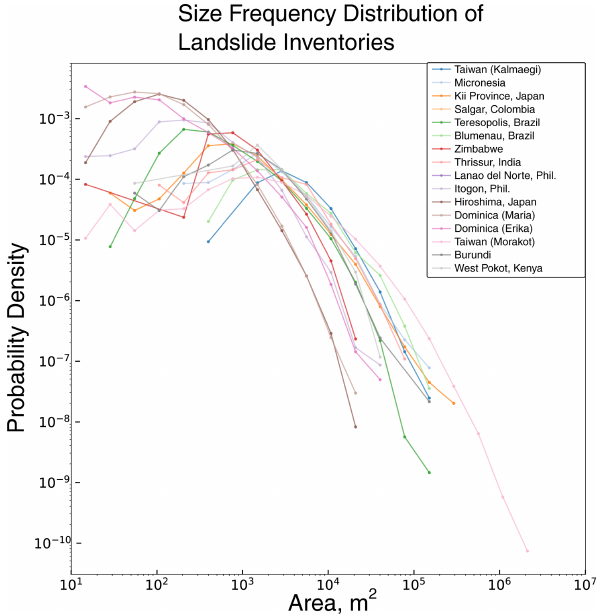
Figure 2. Probability density for landslides in each event inventory, obtained as the number of landslides with areas falling into loga- rithmic bins (consistent bins for all inventories), N [ A : A + dA ] , nor- malized by the bin width, dA , and the total number of slides for the event, N tot (see Malamud et al.,